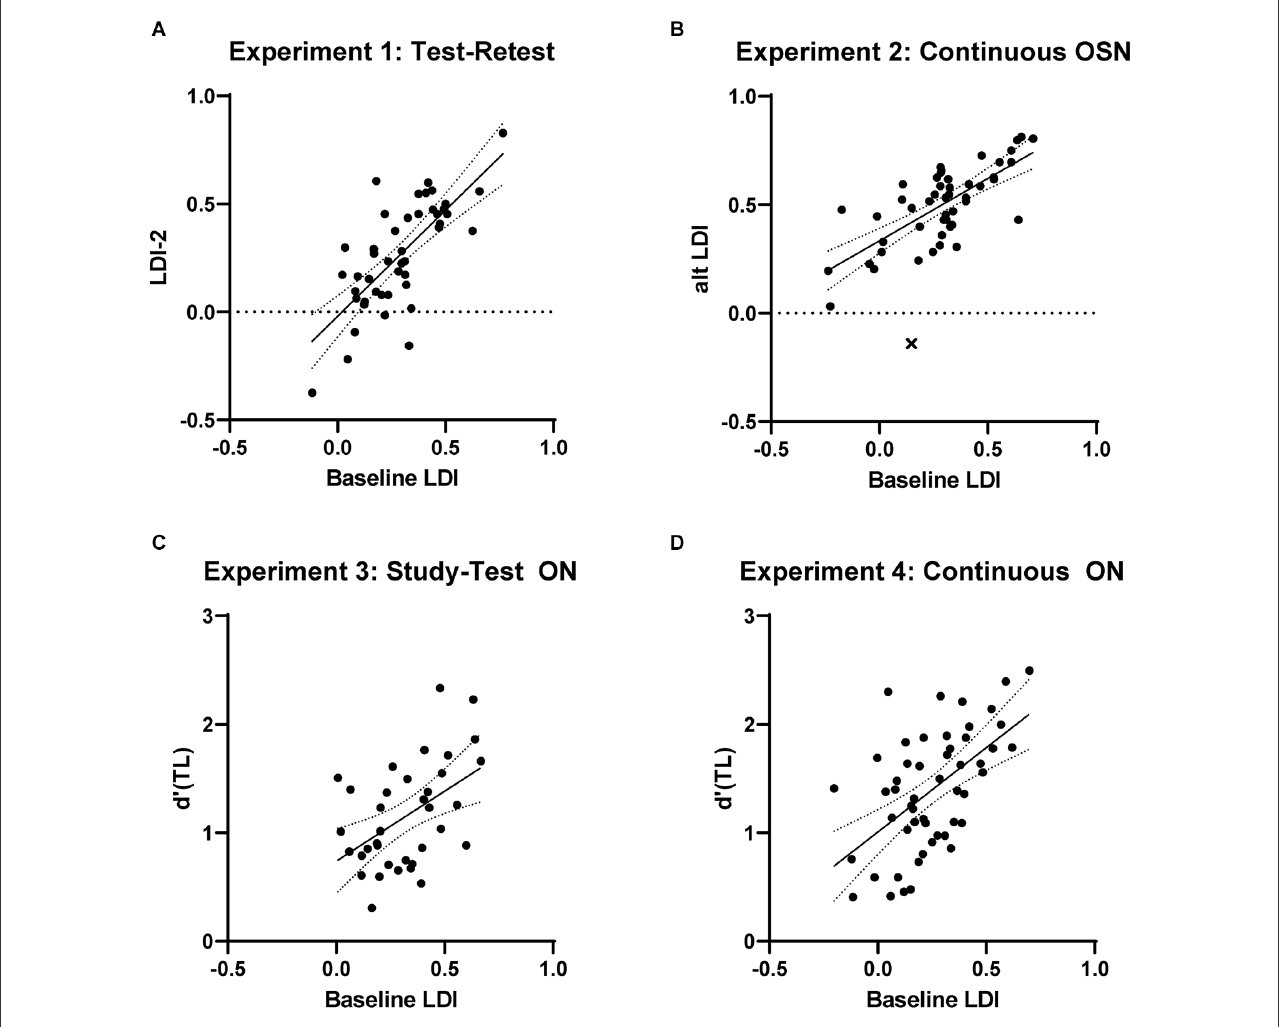
FIGURE2 (A) Results from Experiment 1 showing the baseline test-retest reliability of the MST’s LDI. (B–D) Results from experiments 2–4 showing performance on the baseline, full-length, study-test MST’s LDI metric vs. alternate task LDI scores using: (B) the continuous format and old-similar-new prompt, (C) the study-test format and old-new prompt, and (D) the continuous format and old-new prompt. There is no apparent decrease in performance using the continuous task, but use of the old-new testing prompts reduces the correlation with baseline LDI. Points flagged as outliers indicated by